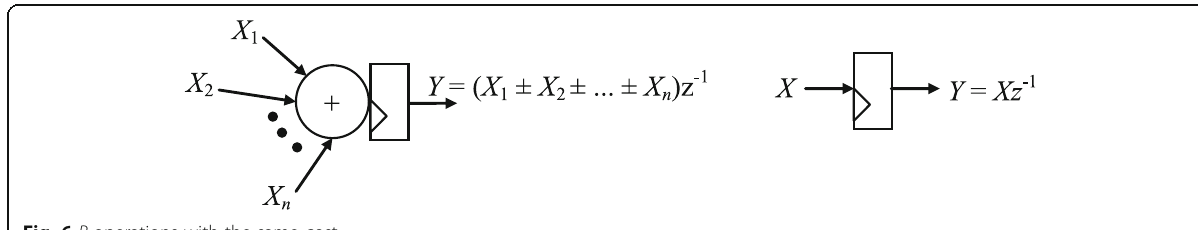
Fig. 6 R- operations with the same